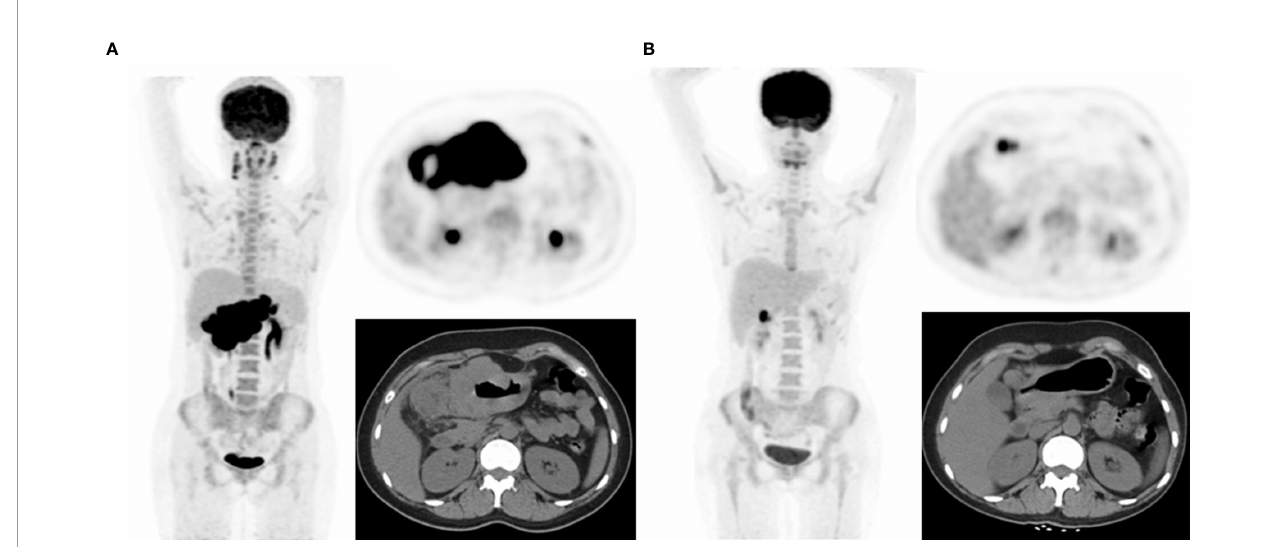
FIGURE 1 | A representative case of a 25-year-old female with stage IIIA BL and both nodal and extranodal disease. Baseline maximum intensity projection (MIP) (A) showing hypermetabolic lesion in stomach and abdominal nodes. End of treatment PET/CT (B) showing high 18F-FDG uptake residual lesion in the lymph node of gastric, considering a partial response compared to baseline scan. This patient died nine months after baseline PET/CT.